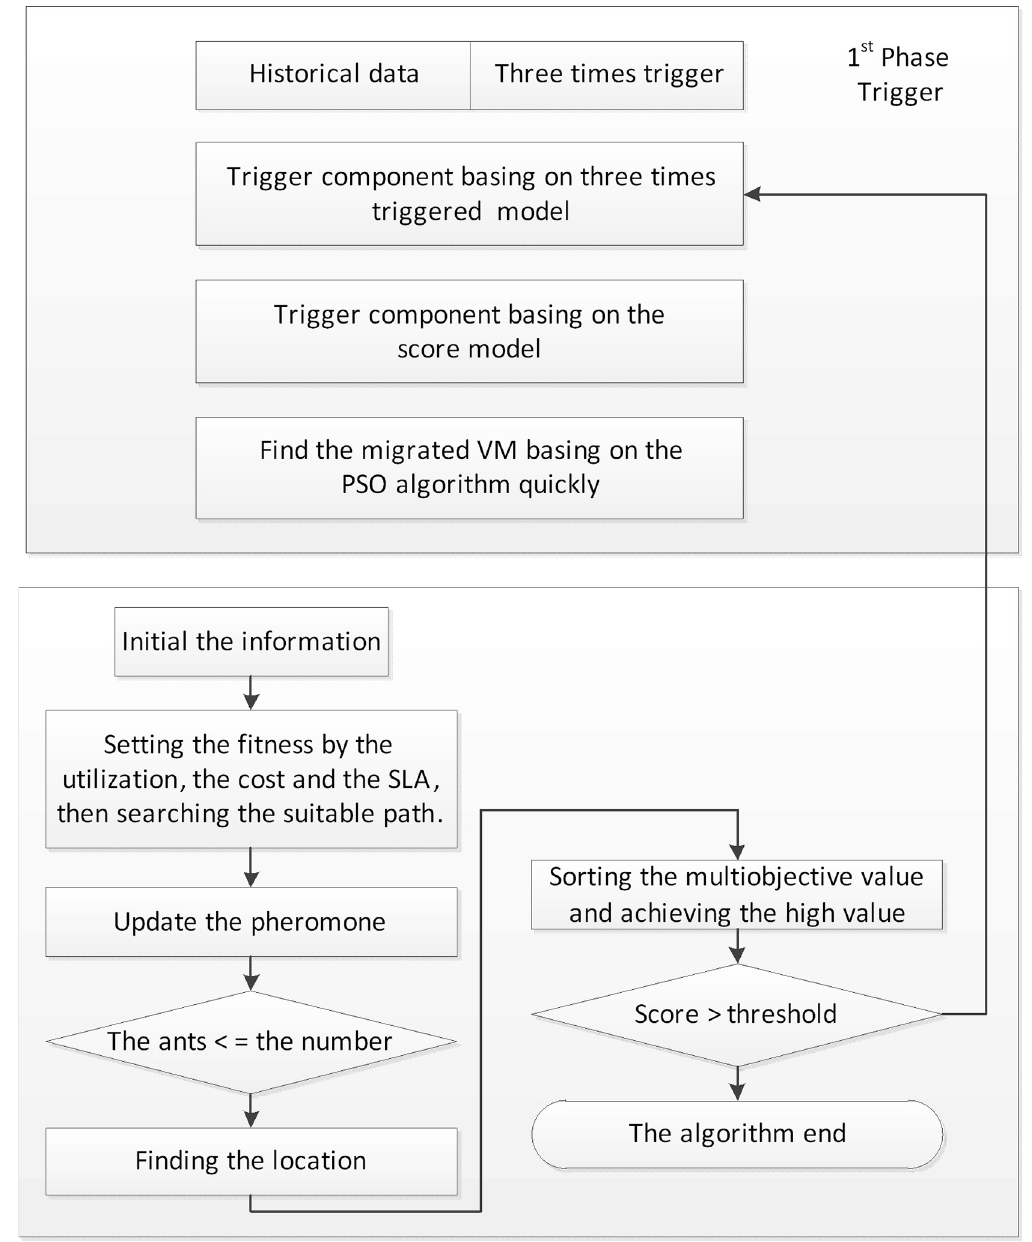
Fig 1. Two-level hybrid heuristic